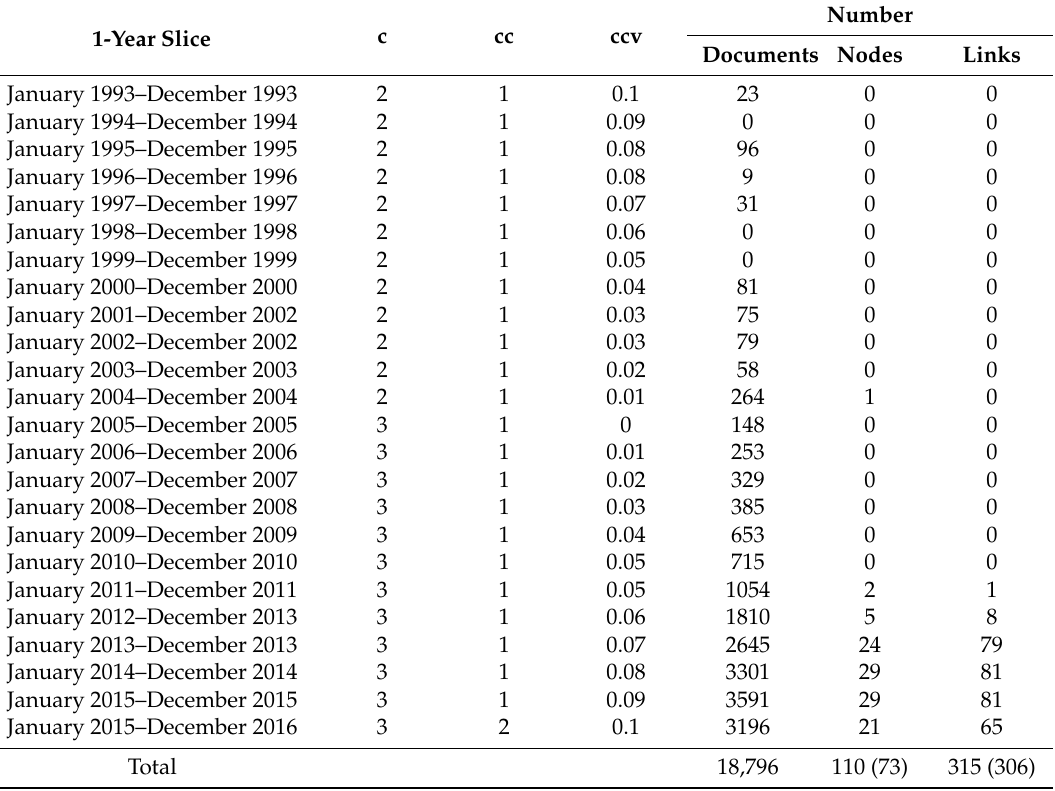
Table 5. The construction configuration for 73 documents co-citation network.